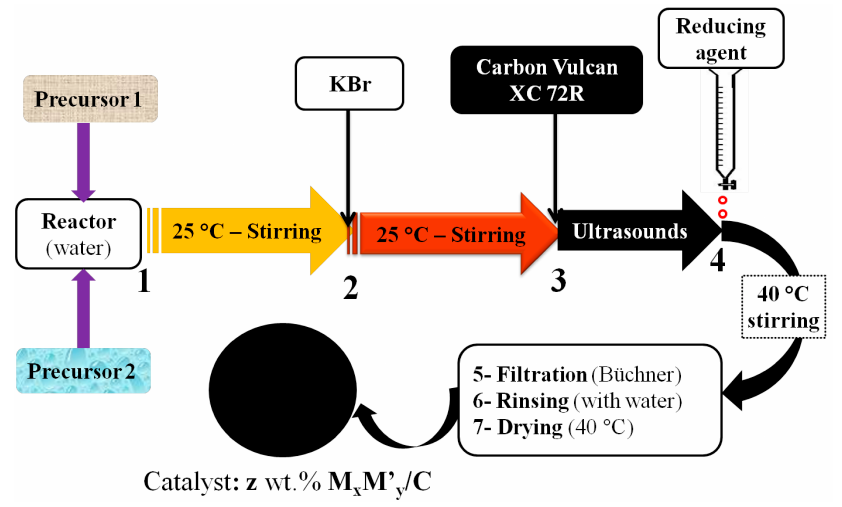
Figure 6. The experimental setup of the Bromide Anion Exchange (BAE) route for nanoscale materials synthesis. Reproduced with permission from Ref. [37] Copyright 2014, The Electrochemical